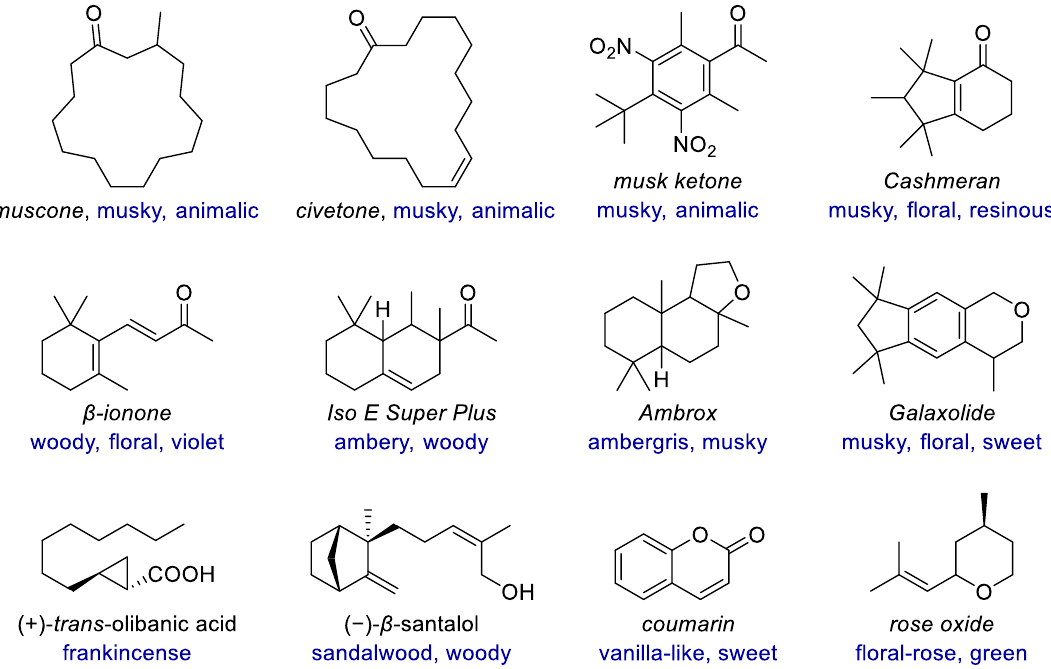
(Figure 1). The ring sizes range from that of cyclopropane in olibanic acid to the macrocycles in muscone and civetone. Diverse types of rings, including carbocyclic and heterocyclic, saturated and unsaturated, aromatic and non-aromatic, monocyclic and polycyclic rings exist in both natural and synthetic fragrances. With highly structural diversity and the resulting tunable odor characters, cyclic fragrances have emerged as molecular probes for exploring olfactory chemical space. New synthetic methods enable much more structural diversity of fragrances, including the scaffold diversity of different rings and their linking modes, as well as the variations of substituents and their replacement by heteroatoms. These compounds include not only derivatives and analogs of natural fragrances but also those compounds with novel scaffolds due to rational design or unexpected findings.